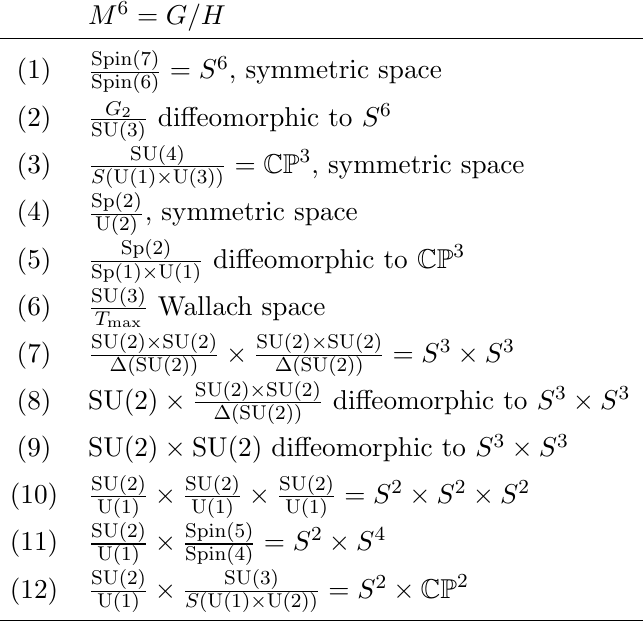
Table 1 . 6-dimensional compact, simply connected, homogeneous